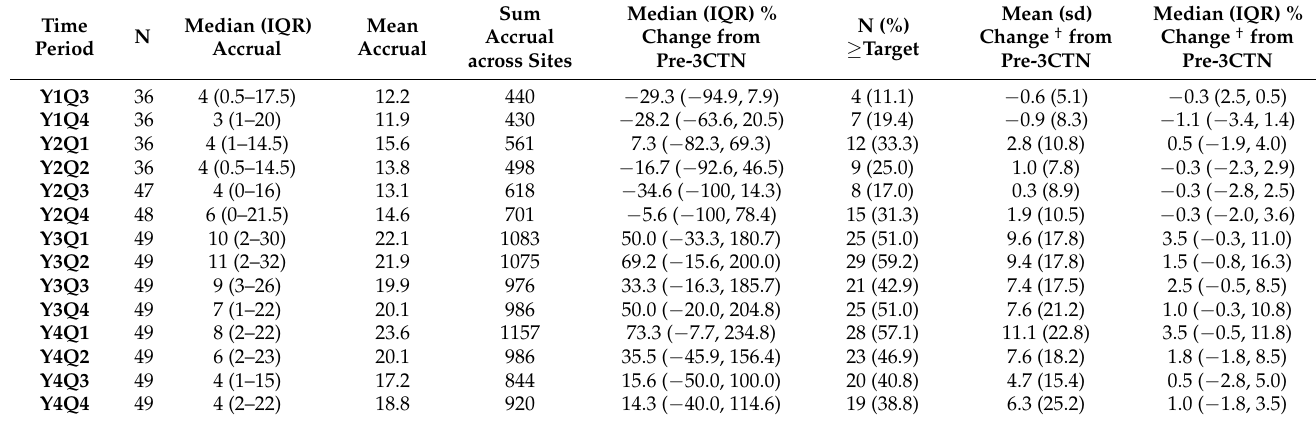
Table 3. Quarterly accrual at Network